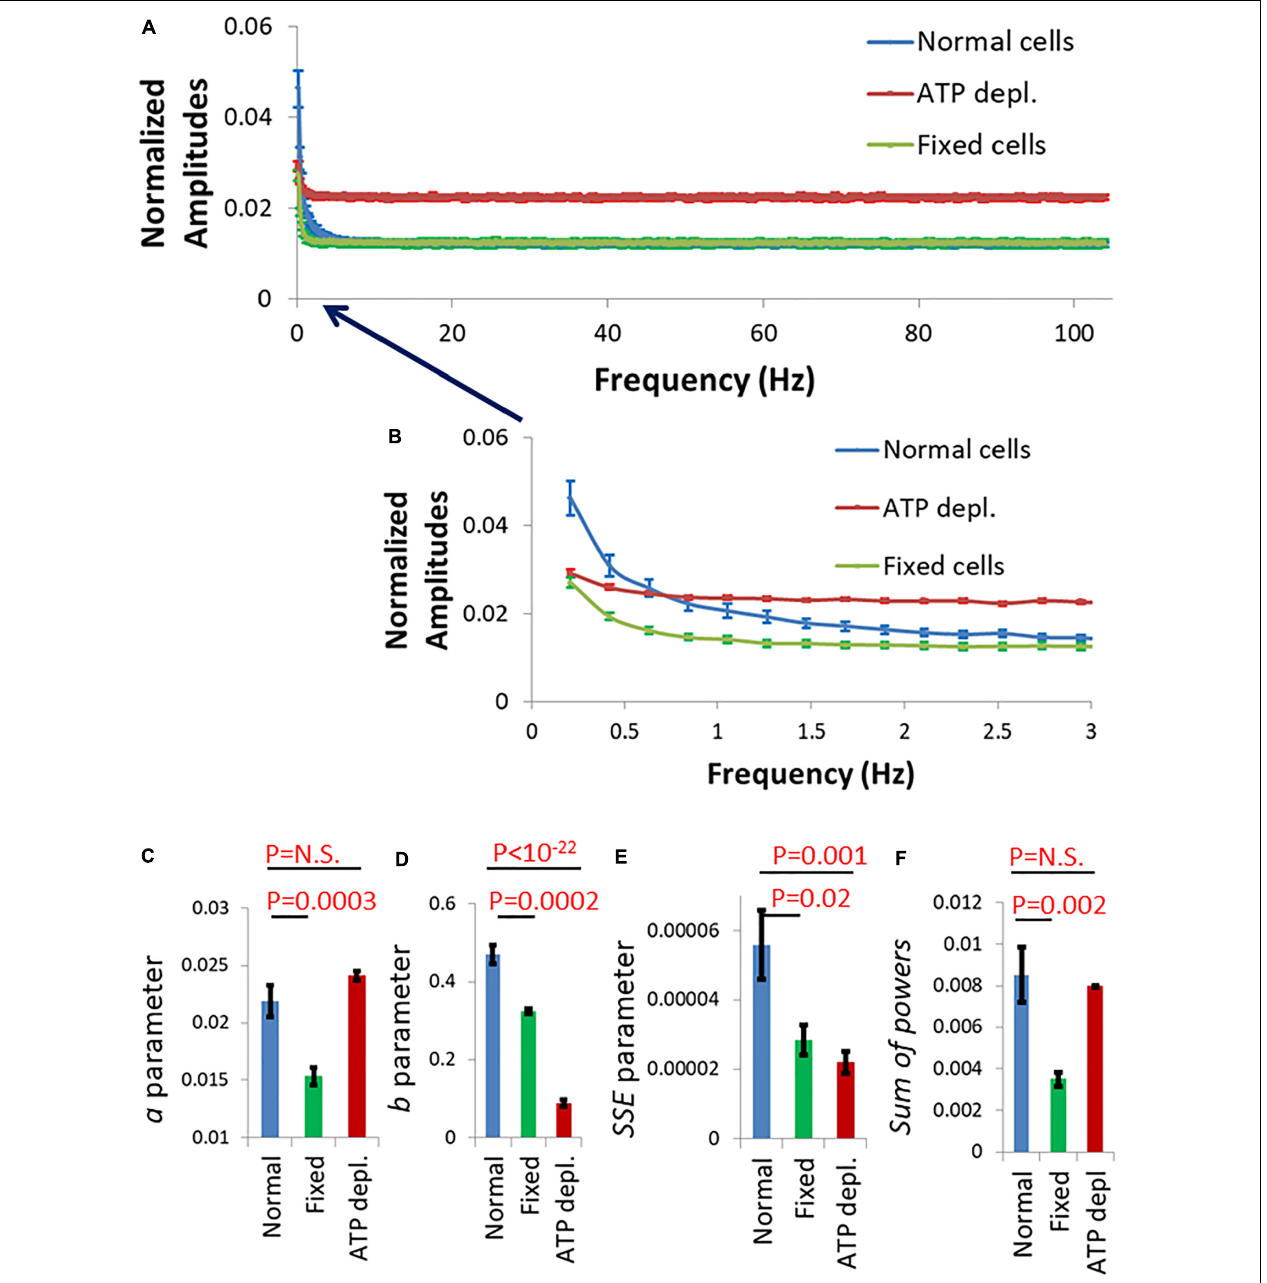
FIGURE 10 | Fluctuation of Jurkat cell membrane in a model of the immune synapse imaged by TIRF microscopy. (A) Discrete Fourier Transform (DFT) results of fluctuations of normalized intensity of anti-CD45 antibodies labeled with Alexa647, which highlighted the plasma membrane of Jurkat cells. The cells adhered to coverslips coated with anti-CD3 ε . Amplitudes of normal cells ( N = 30) are in blue, adenosine triphosphate (ATP) depleted cells ( N = 33) are in red and fixed cells ( N = 24) are in green. (B) Frequency range of 0–3 Hz of the amplitudes in (A) . Power fit parameters: a (C) , b (D) , sum of squared errors ( SSE ) (E) , and Sum of powers (F) results of the amplitudes presented in (B) . Error bars in panels (A–F) are